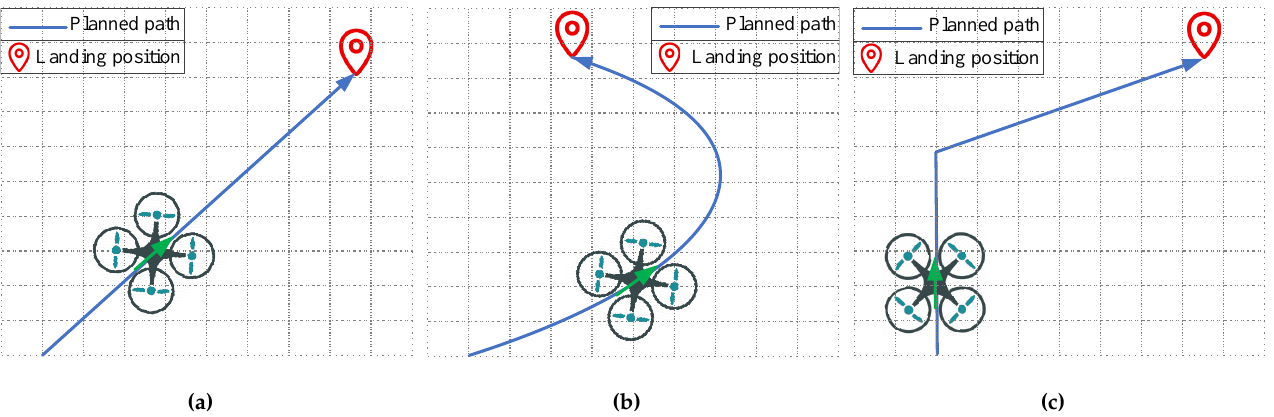
Figure 5. Flight paths. ( a ) Straight line path; ( b ) Curved line path; ( c ) Turning path.